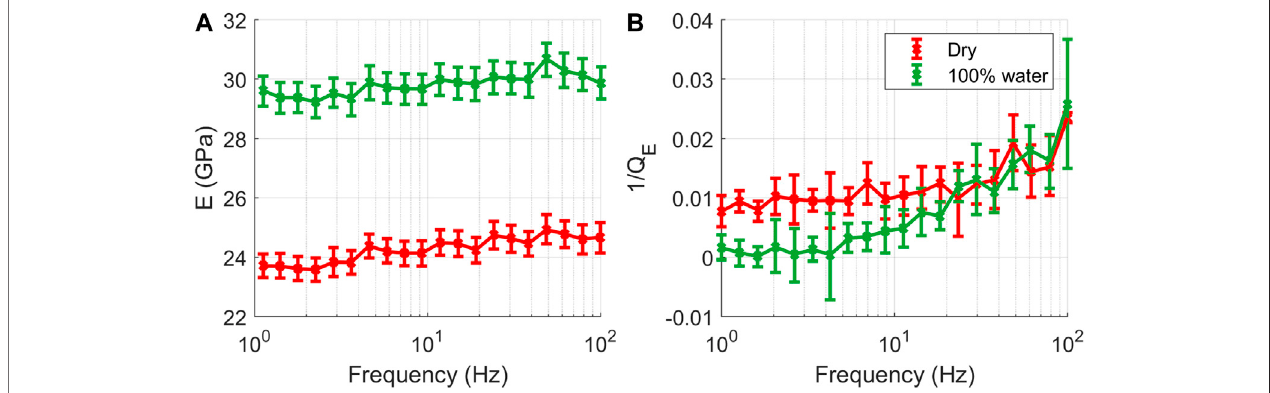
FIGURE 7 | Laboratory measurements of Young ’ s modulus (E) and attenuation (1/Q E ) for the carbonate under dry conditions and full saturation (100%) with water (1 cP) at con fi ning pressures of 5 MPa.